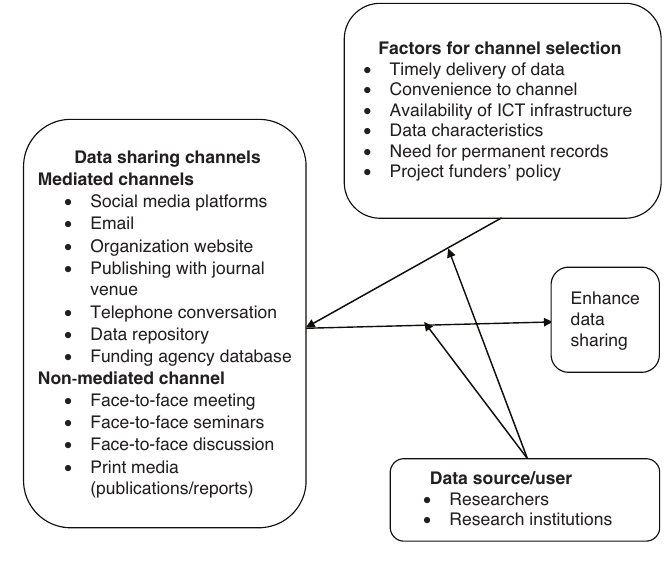
Fig. 2: Conceptual framework showing the relationship exist between the variables for this